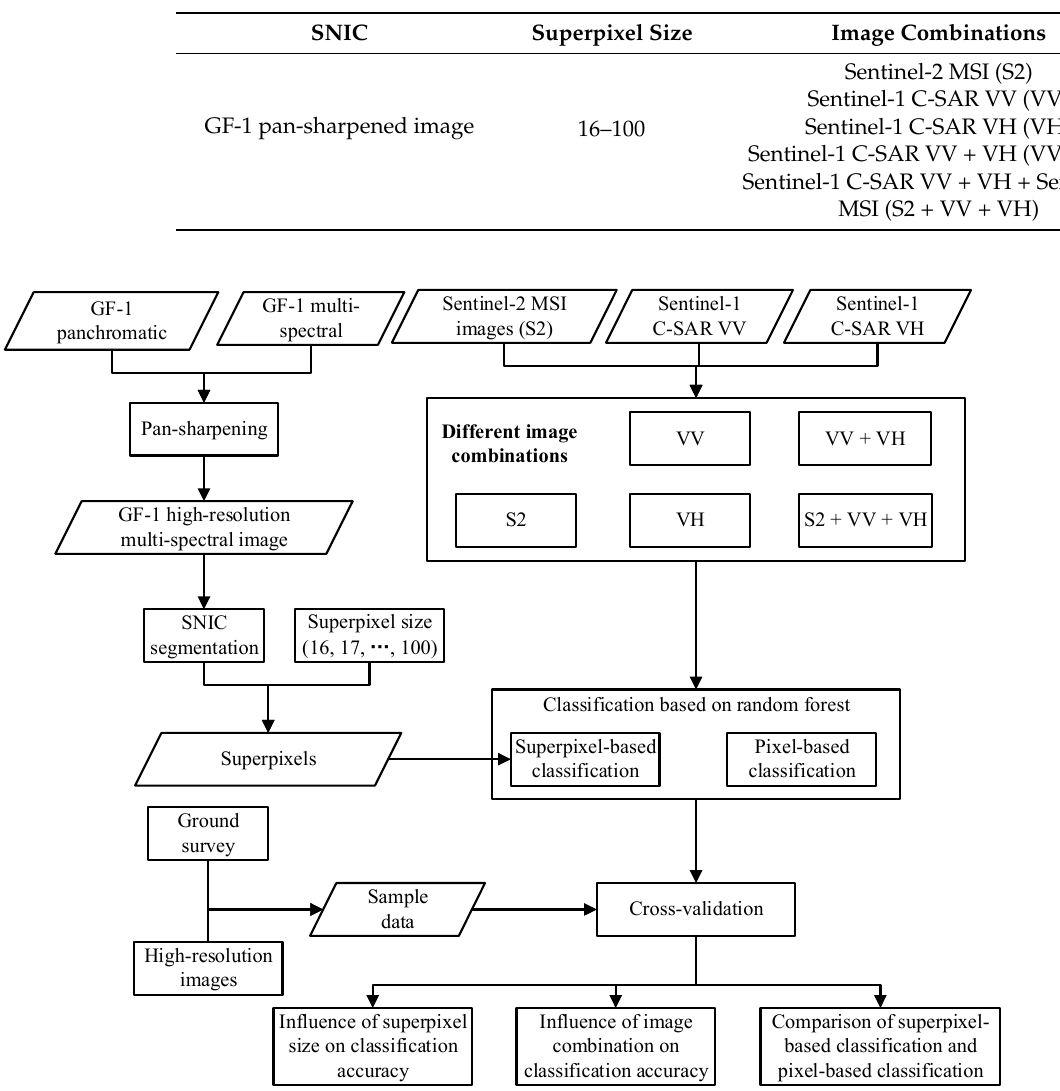
Table 3. Classification schemes.